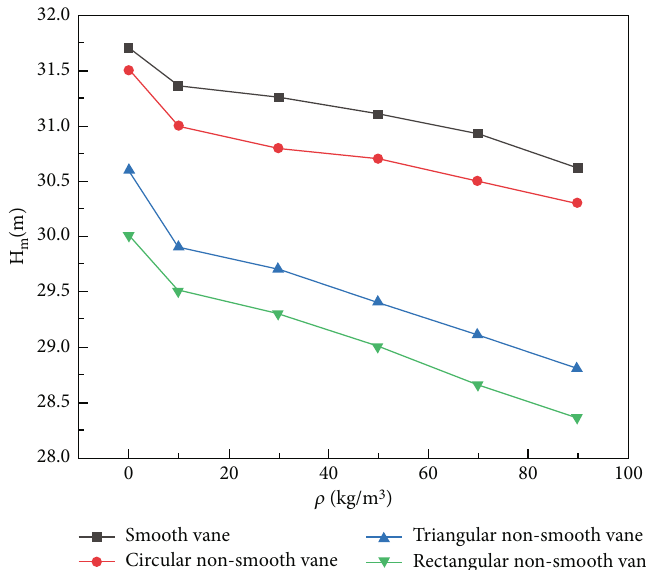
Figure 5: Particle concentration-head curve of a double-vane pump.